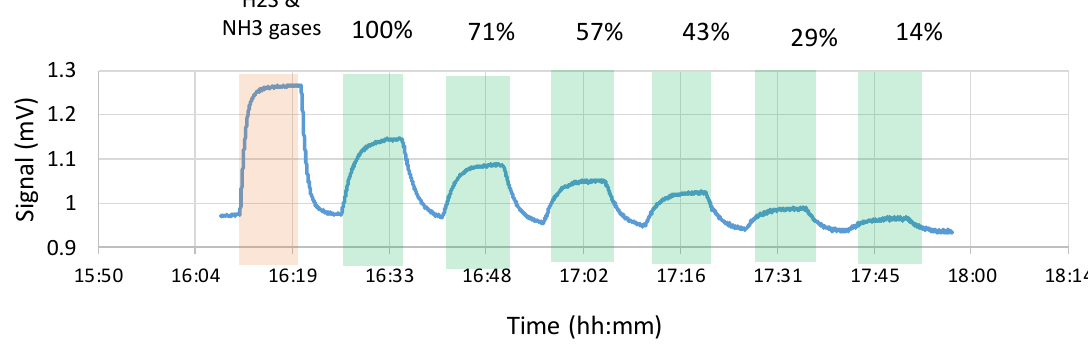
Figure 2. Typical dose response vs. time for Membrapor formaldehyde sensor when exposed to air containing fecal odor. The green bands indicate exposure to malodor. The values above the graph indicate the concentration with respect to the original odor sample (i.e., 100% is undiluted, 71% means 71% odor sample, and 29% odorless air).